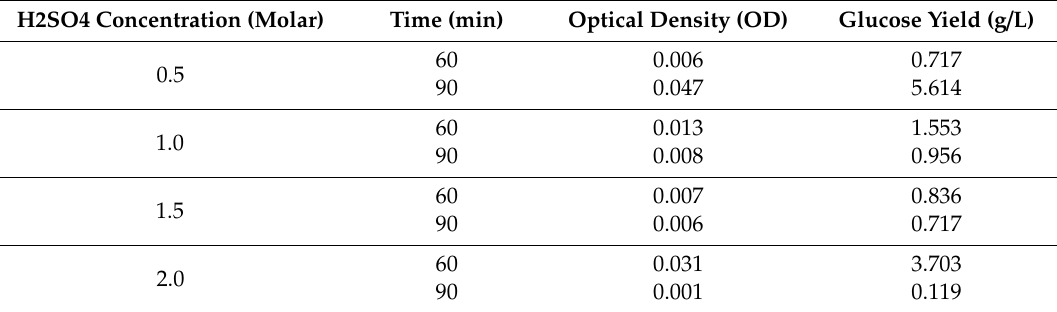
Table 1. Glucose yield during acid hydrolysis.